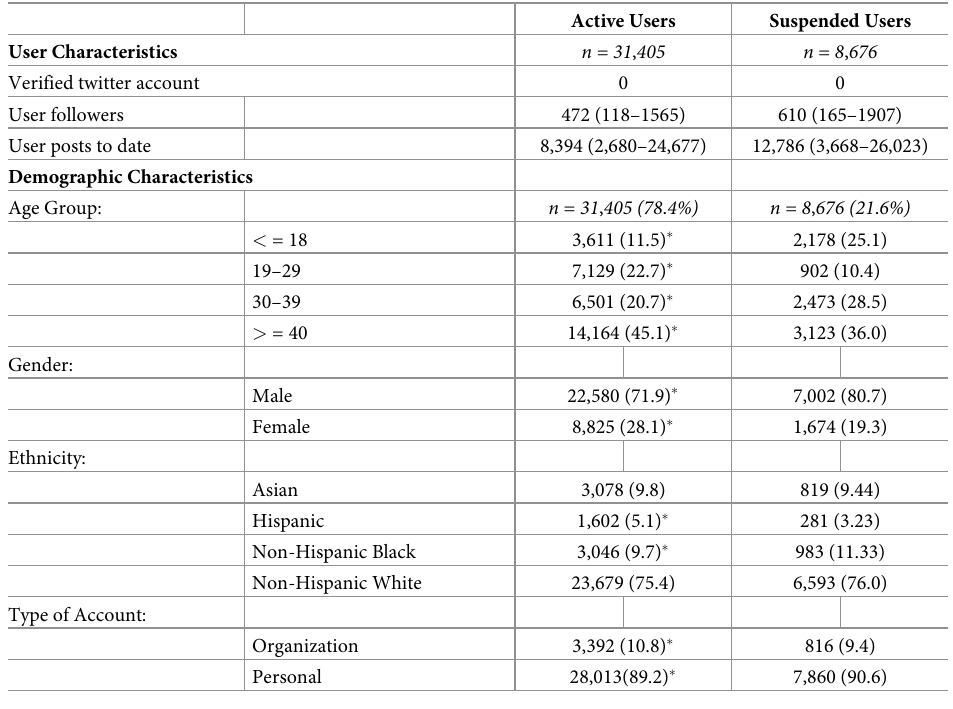
Table 1. Characteristics of Twitter